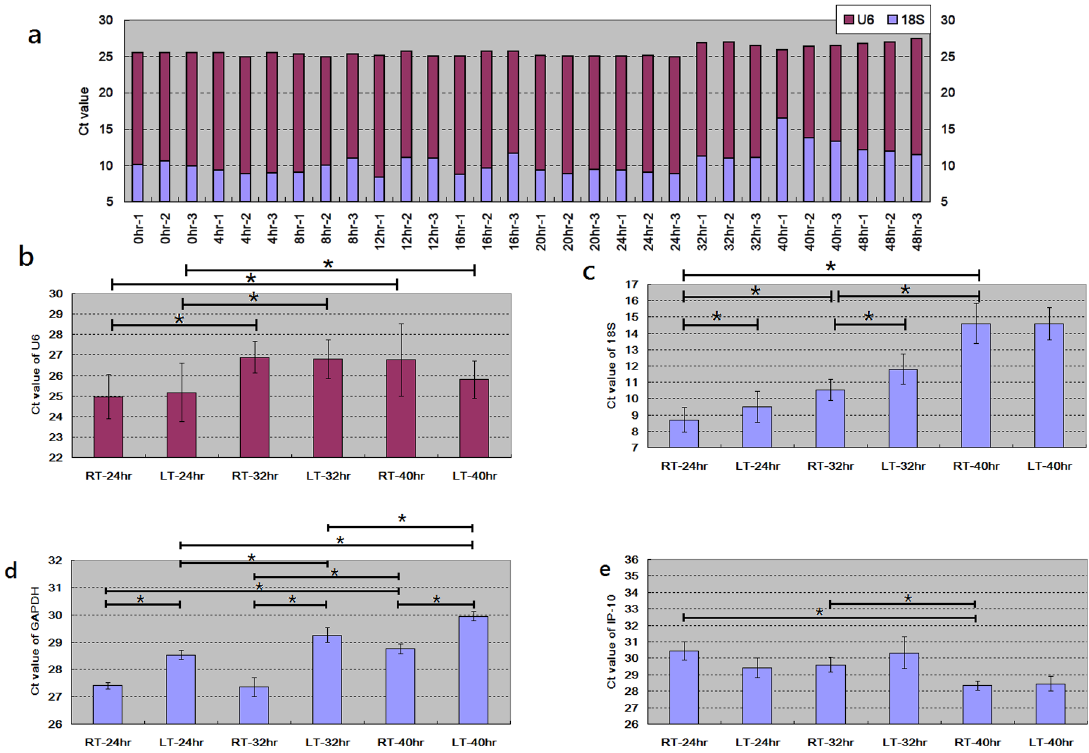
Fig 2. Examinations of qPCR Ct value on samples with different storage temperatures and storage durations. * denotedsignificanceby t-test. (a) All blood samples were collectedfrom one single subject and stored at 24˚C. The Ct values of U6 and 18S significantly rose at the durationof 32hr. (b,c,d,e) Thirty bloodsamples were collectedfrom 10 subjects (N = 30) for each condition.Consistent with Fig 1, with longerduration, more RNA decayed and less U6, 18S and GAPDH mRNA detected. Compared with room temperature, low temperature did not protect genesfrom further degradation. Data was presented as mean ± SD.